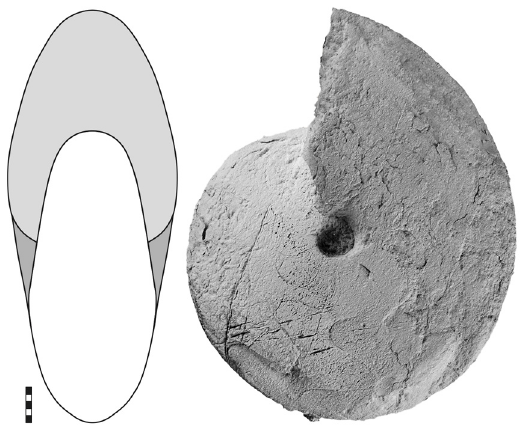
Fig. 16. Pseudogastrioceras relicuum Korn & Ghaderi, 2016, lateral and reconstructed dorsal views of specimen MB.C.29661. Scale bar units = 1 mm.